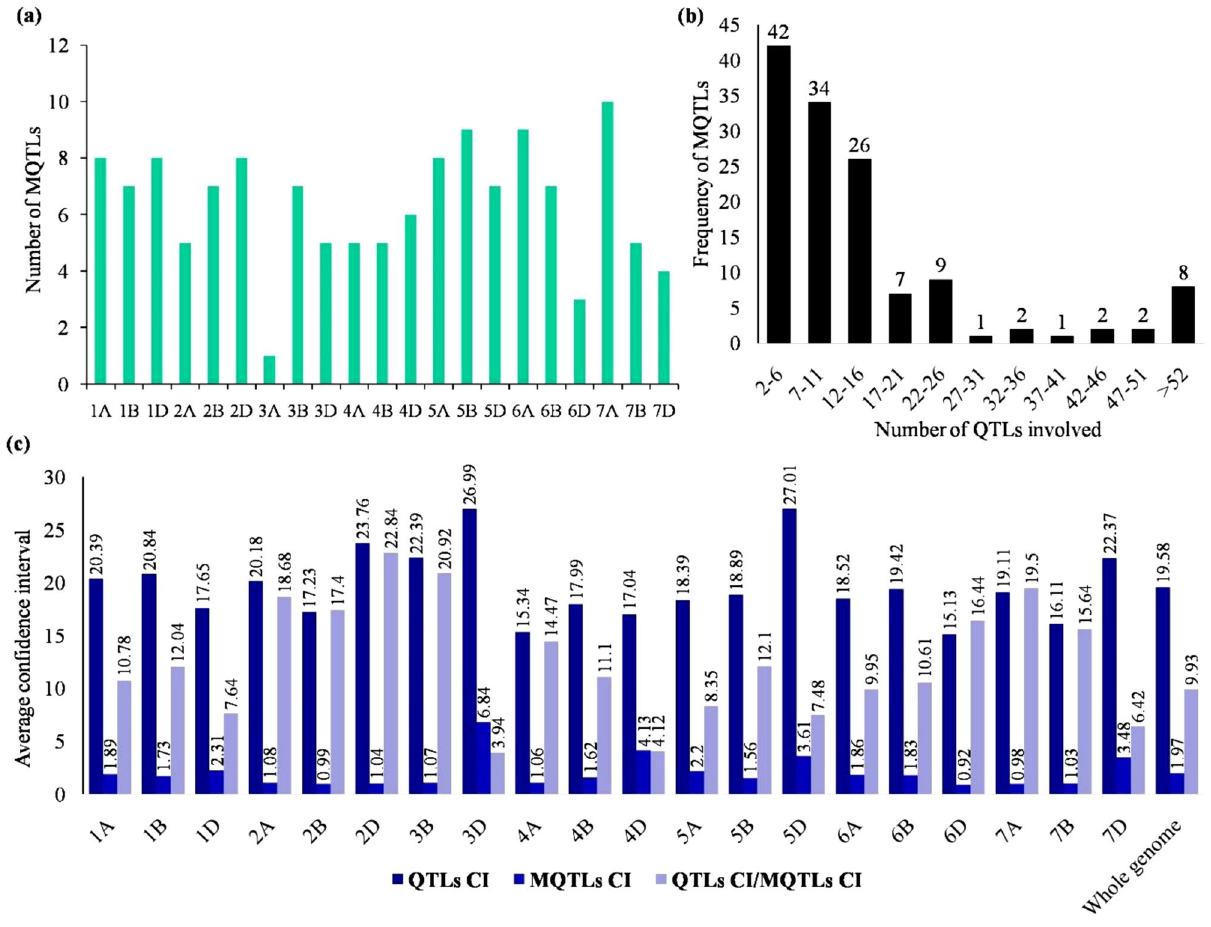
Figure 2. Salient features of MQTLs detected in the current study: ( a ) distribution of MQTLs on different wheat chromosomes, ( b ) frequency of QTLs included in different MQTLs, and ( c ) comparison of CIs of initial QTLs and MQTLs (QTLs CI/MQTLs CI represents the fold reduction in CIs after